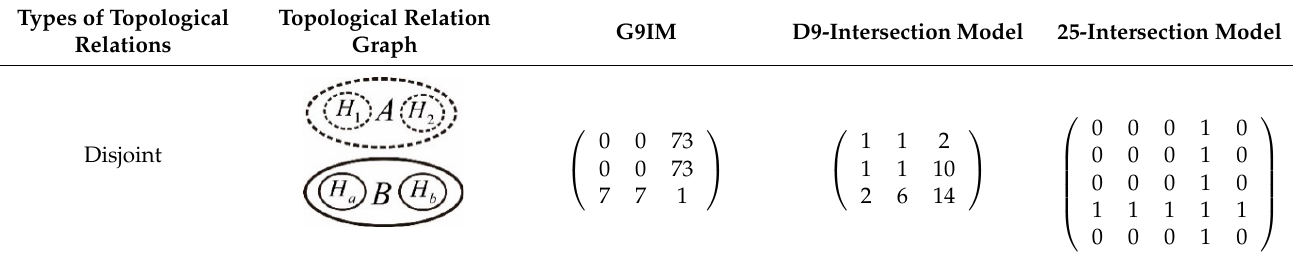
Table 4. Describing results of topological relations between regions with holes using three types of topological representation models.